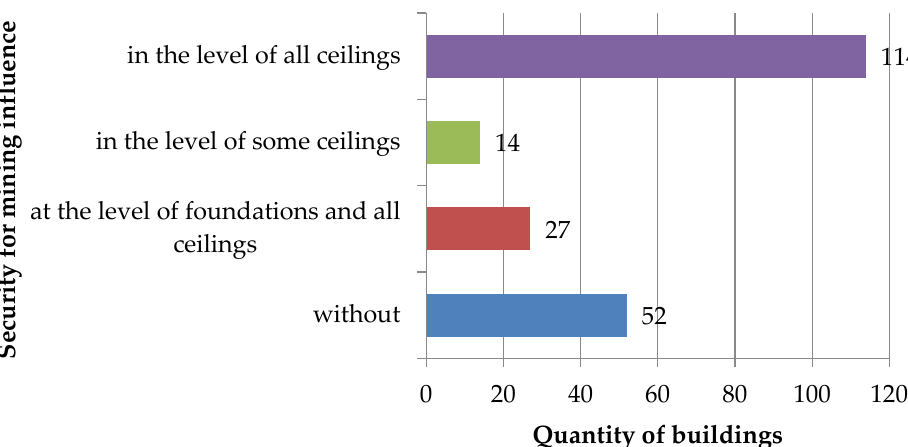
Figure 18. Distribution of data for the variable relating to security for mining influences. 4. Damage Morphology in the Analysed Group of Buildings Each building is classified into one of the four damage categories. These categories take into account the extent and intensity of damage and threats to the safety of the facility and its users [31]. The adopted building damage categories are described below: 1.